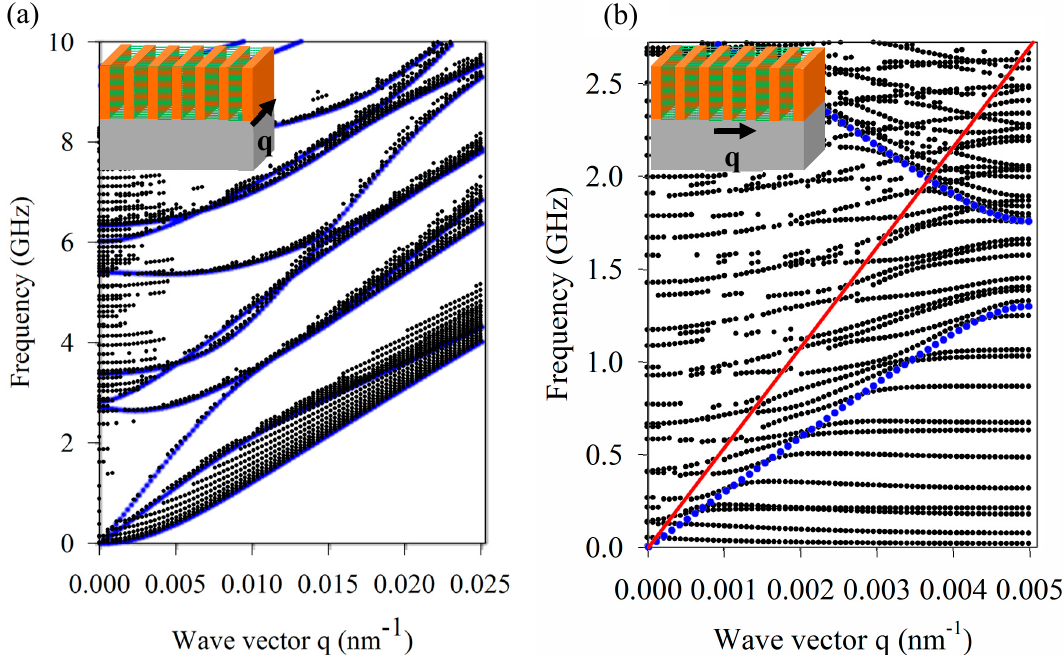
Figure 8. Dispersion curves of the one-dimensional (1D) nanoridge structure of high aspect ratio ( AR ) ( h = 2.7 µm) infiltrated with the liquid (Cargille) ( a ) for the direction parallel to the nanoridges under the condition P xy ( w , q ) ≥ 80% (black curves) and ( b ) for the direction perpendicular to the nanoridges under the condition P yz ( w , q ) ≥ 80% (black curves). The dispersion curves of an infinite 1D epoxy/Cargille multilayer array are reported in blue.